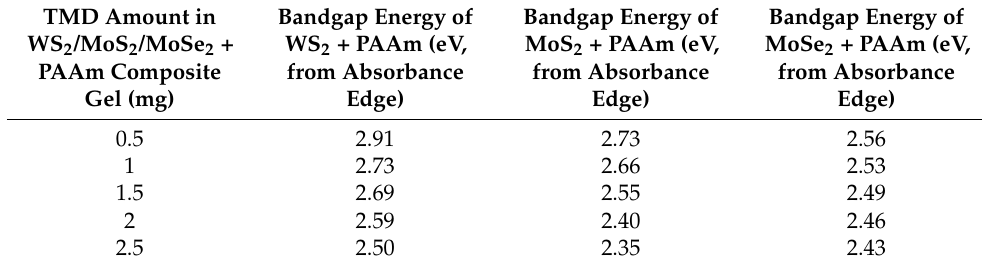
Table 1. The calculated band gap energies of all composites at the absorbance edge. TMD Amount in WS 2 /MoS 2 /MoSe 2